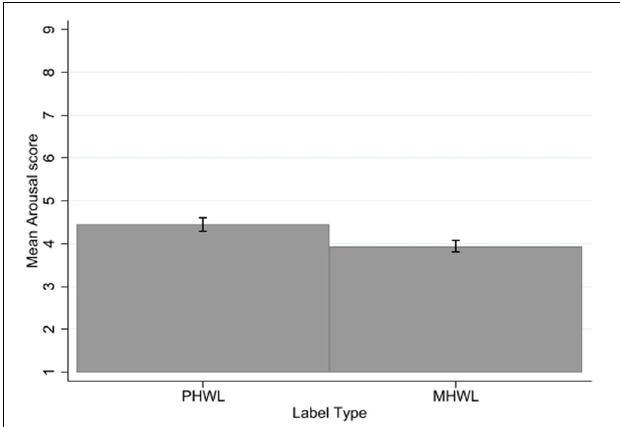
FIGURE 5 | Arousal by label type. Error bars represent 95% confidence intervals.